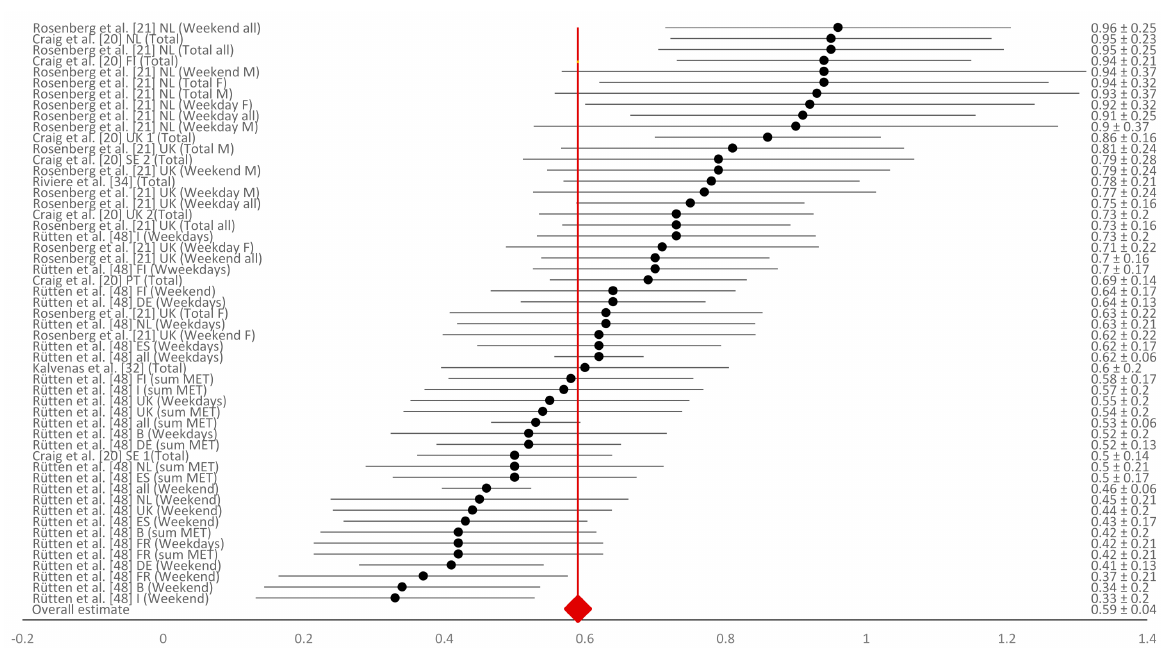
Figure 2. Forest plot of reliability coefficients with 95% confidence intervals. Notes: B—Belgium; DE—Germany; ES— Spain; FI—Finland; FR—France; I—Italy; LT—Lithuania; NL—The Netherlands; PT—Portugal; SE—Sweden; UK—United Kingdom; M—male; F—female.